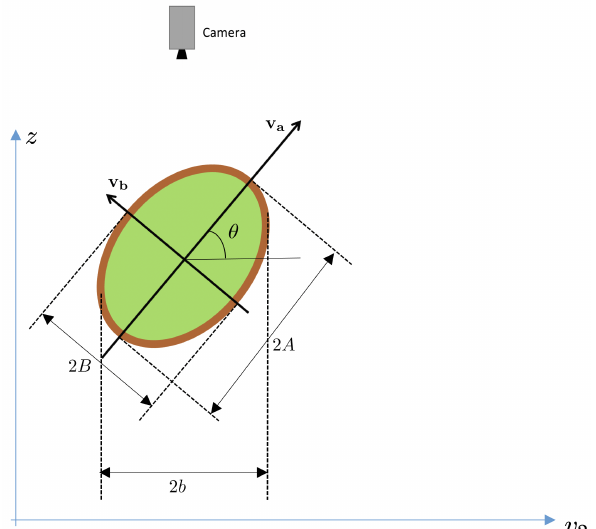
Figure 11. Cross section of fruit across 3D plane v 1 = 0 in Figure 8. Camera position above the fruit is